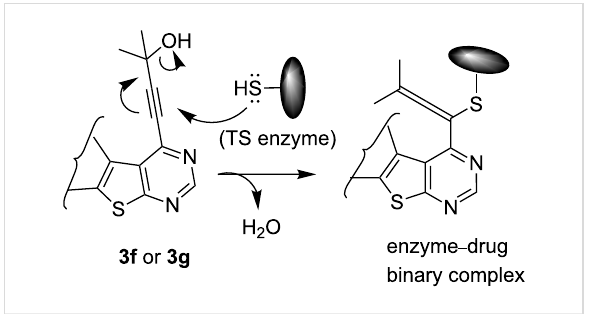
Figure 2: Possible interactions of compounds 3f and 3g with TS